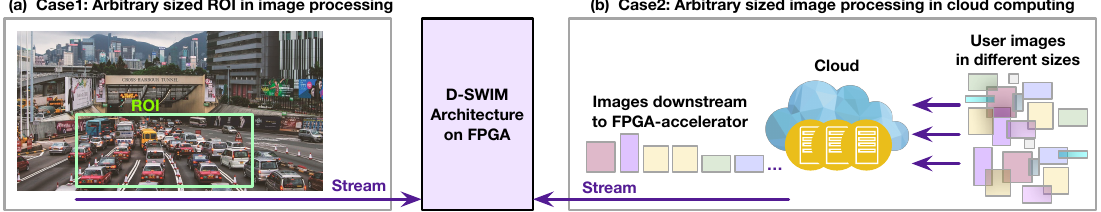
Figure 2. Motivation for arbitrary sized image processing: ( a ) user-defined Region of Interest (ROI) processing; ( b ) arbitrary sized image processing in cloud